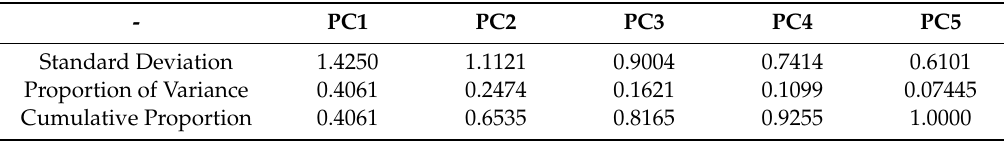
Table 7. Importance of principal components.